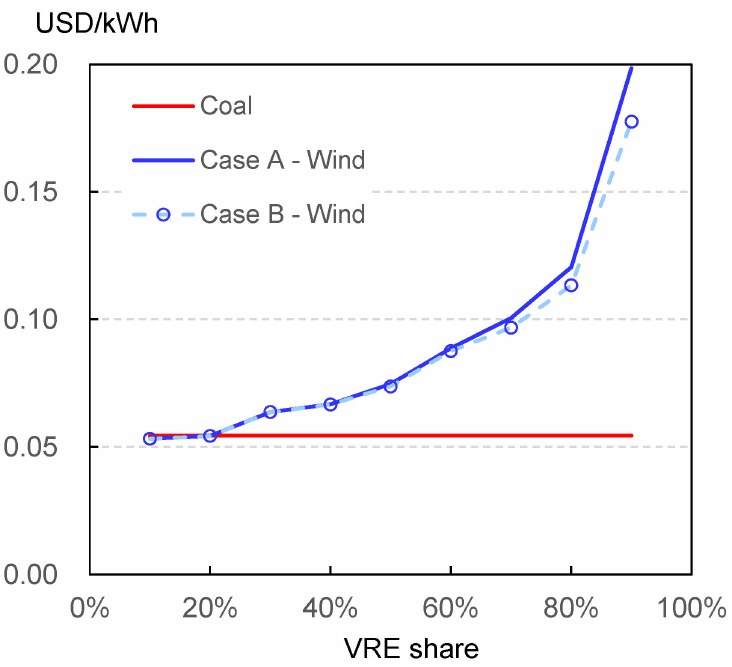
Figure 3. Relative marginal system